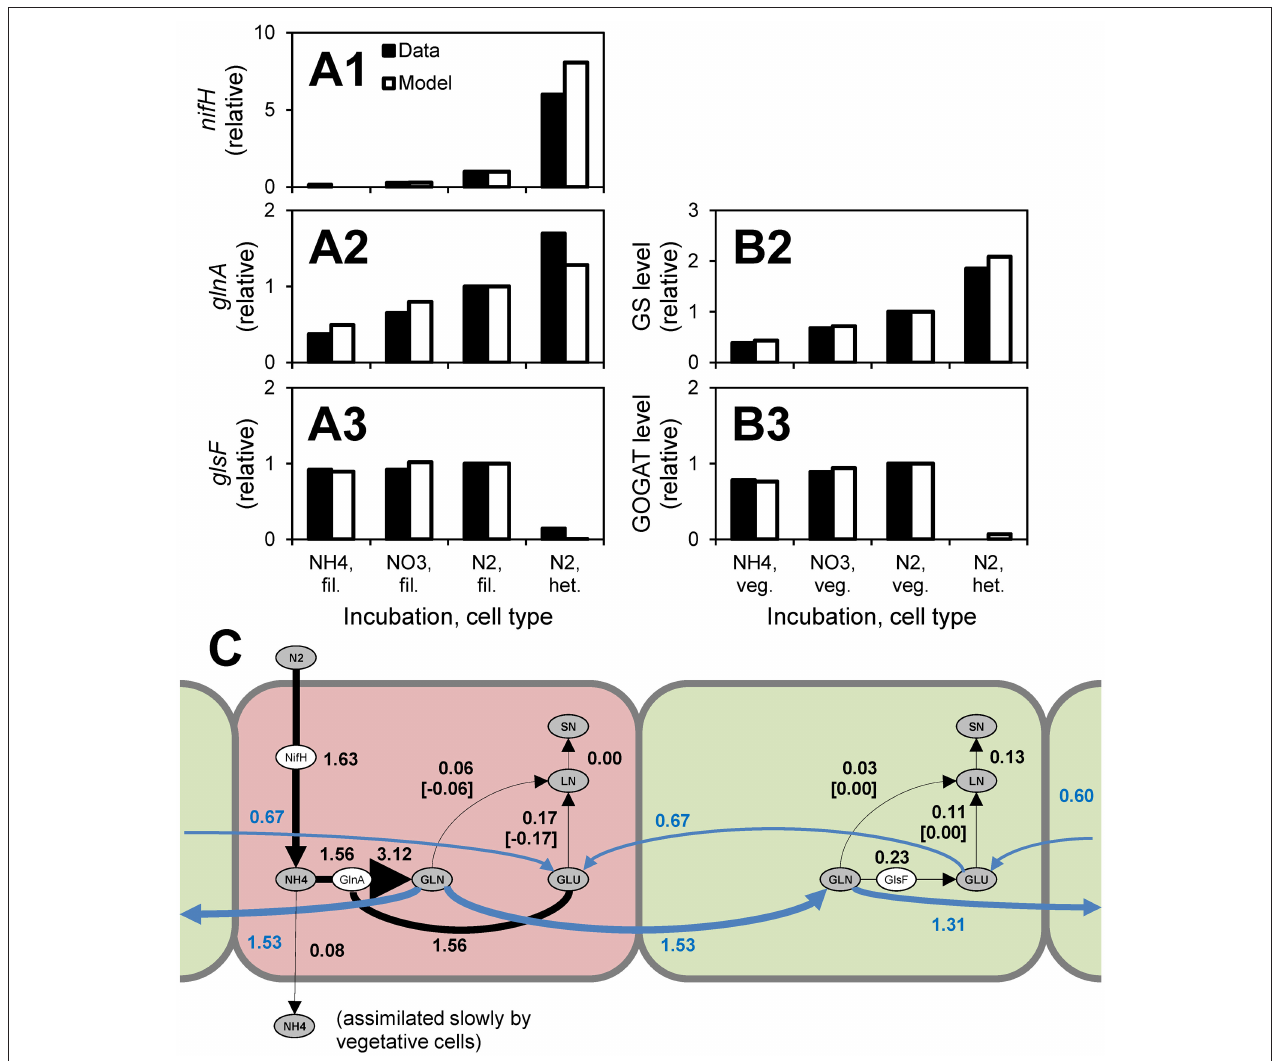
FIGURE 4 | Anabaena —nitrogen interaction model. (A,B) Comparison to observations of transcript levels in filaments (fil., i.e., all cells), vegetative cells (veg.) and heterocysts (het.) (A) and enzyme activities (B) of cells grown under different conditions (data are from Martin-Figueroa et al., 2000). (C) N fluxes for growth on N 2 . Red, heterocysts; Green, vegetative cells. Numbers are fluxes in pmol N cell − 1 d − 1 . From Hellweger et al. (2016b). The figure shows that heterocysts have higher levels of nitrogenase ( nifH ) transcripts, higher levels of glutamine synthetase ( glnA , GS) transcripts and enzyme levels and lower levels of glutamate synthase ( glsF , GOGAT) transcripts and enzyme activities. These observations support the model where N 2 is fixed in heterocysts and combined with glutamate (GLU) that is imported from adjacent vegetative cells to yield glutamine (GLU), which is then exported to vegetative cells and further incorporated into labile nitrogen (LN) and structural nitrogen (SN)